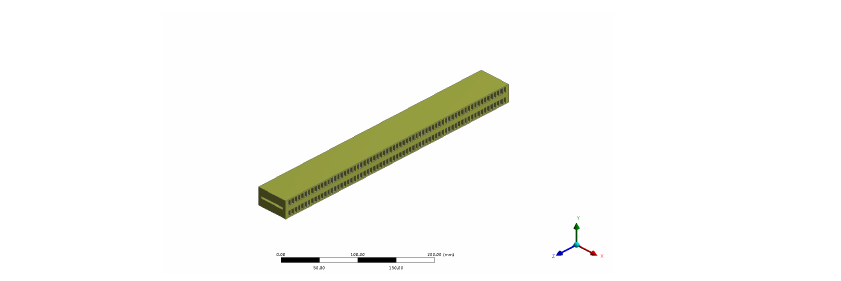
Fig. 1. Three-dimensional model of the radiator basic unit.